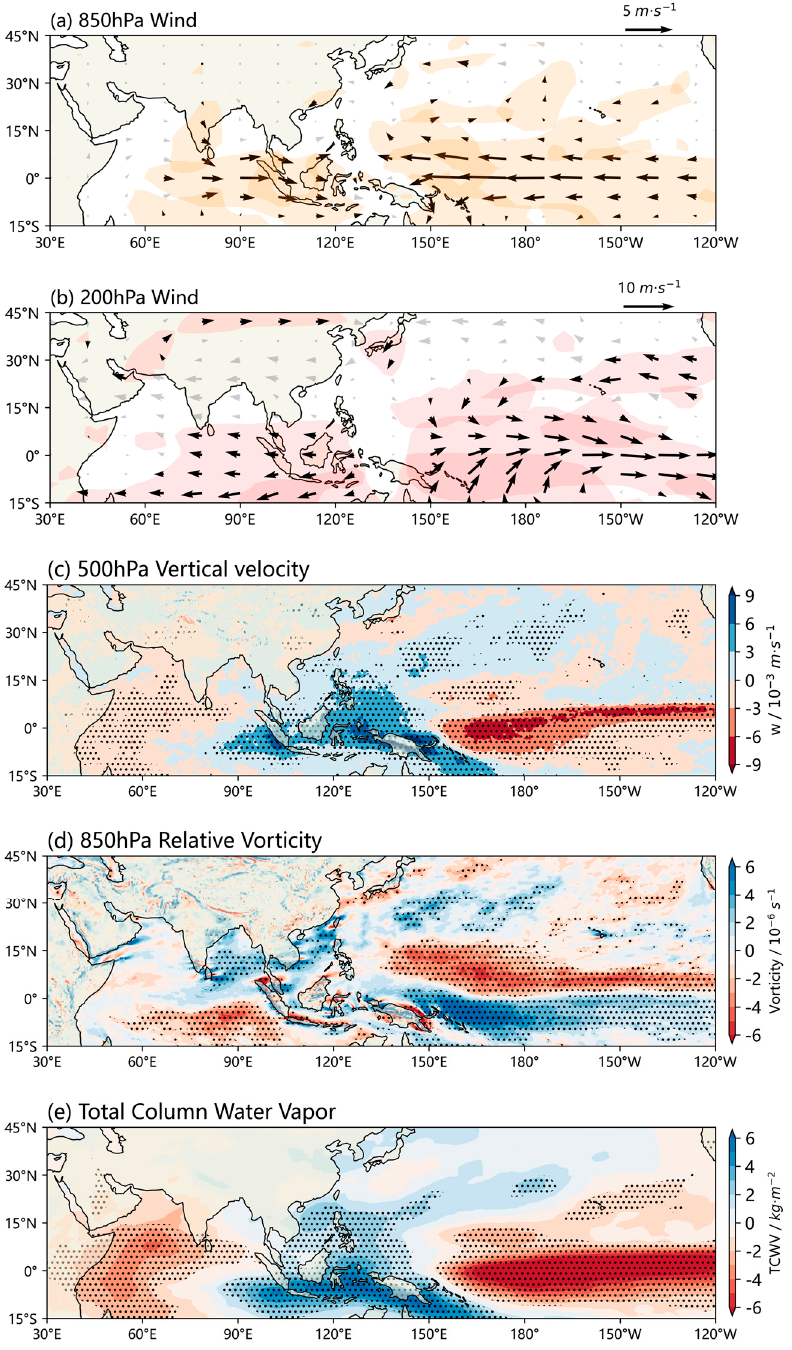
Figure 10. Distribution differences (strong years minus weak years) of ( a ) 850 hPa wind (arrow, unit: m/s); ( b ) 200 hPa wind (arrow, unit: m/s); ( c ) 500 hPa vertical velocity (shade, unit: 10 − 3 m/s); ( d ) 850 hPa relative vorticity (shade, unit: 10 − 6 s − 1 ); ( e ) total column water vapor (shade, unit: kg/m 2 ) over the tropical Indo-Pacific Ocean during TC season (May to December) in SCSSM anomalous years. Shaded areas in ( a , b ) and dotted areas in ( c – e ) are statistically significant at the 90% confidence level.